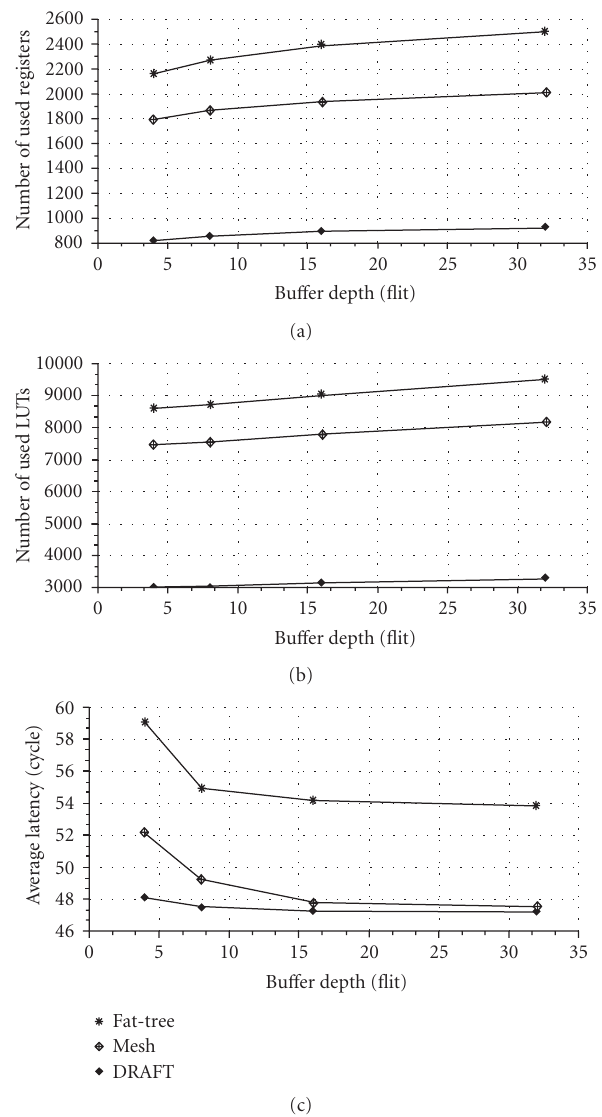
Figure 16: Influence of the bu ff er depths over the hardware resources (registers (a) and LUTs (b)) and the latencies (c) with a data rate of 800 Mbit/s per CE.